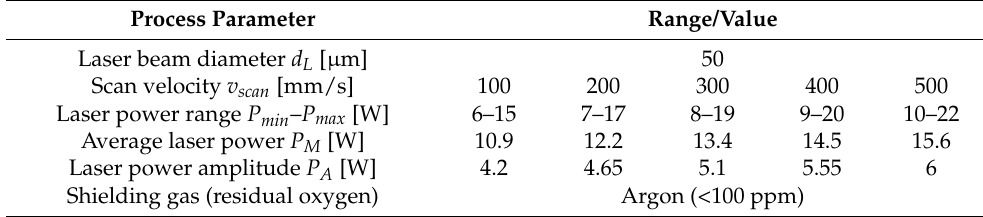
Table 2. Tabular overview of process parameters and range of